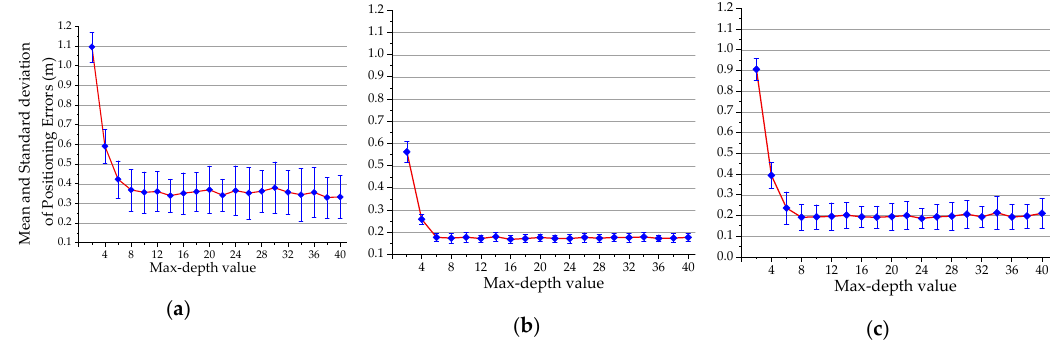
Figure 18. Mean and standard deviation of positioning errors vs. max-depth by: ( a ) whole floor, ( b ) center area, and ( c ) edge area.